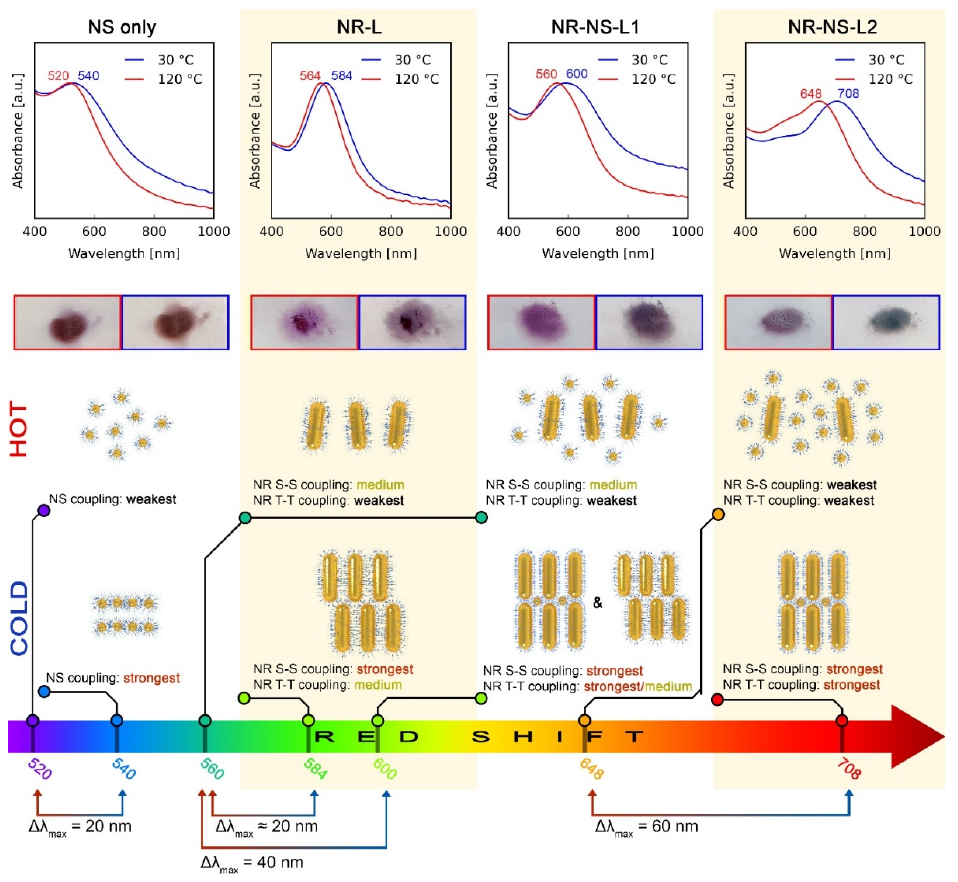
Figure 3. Far-field optical properties of NS, NR-L, NR-NS-L1 and NR-NS-L2 films (consecutive columns). Consecutive rows represent: (1st row) UV–vis spectra of a given material at 30 and 120 ◦ C (blue and red curves, respectively). (2nd row) Optical images of the films on a glass substrate at 30 and 120 ◦ C (the longer side of the rectangle represents 10 mm). (3rd row) Idealized arrangements of NPs at 30 and 120 ◦ C that were used to model UV–vis with a brief description of plasmonic coupling within that arrangement. S-S and T-T refer to side-to-side and tip-to-tip coupling between NRs, respectively. More details on the UV–vis modeling are given in Figure 4 and Supplementary Note 2. (4th row) λ max values represented on a common wavelength axis to depict the relations of λ max and ∆ λ max on thermal